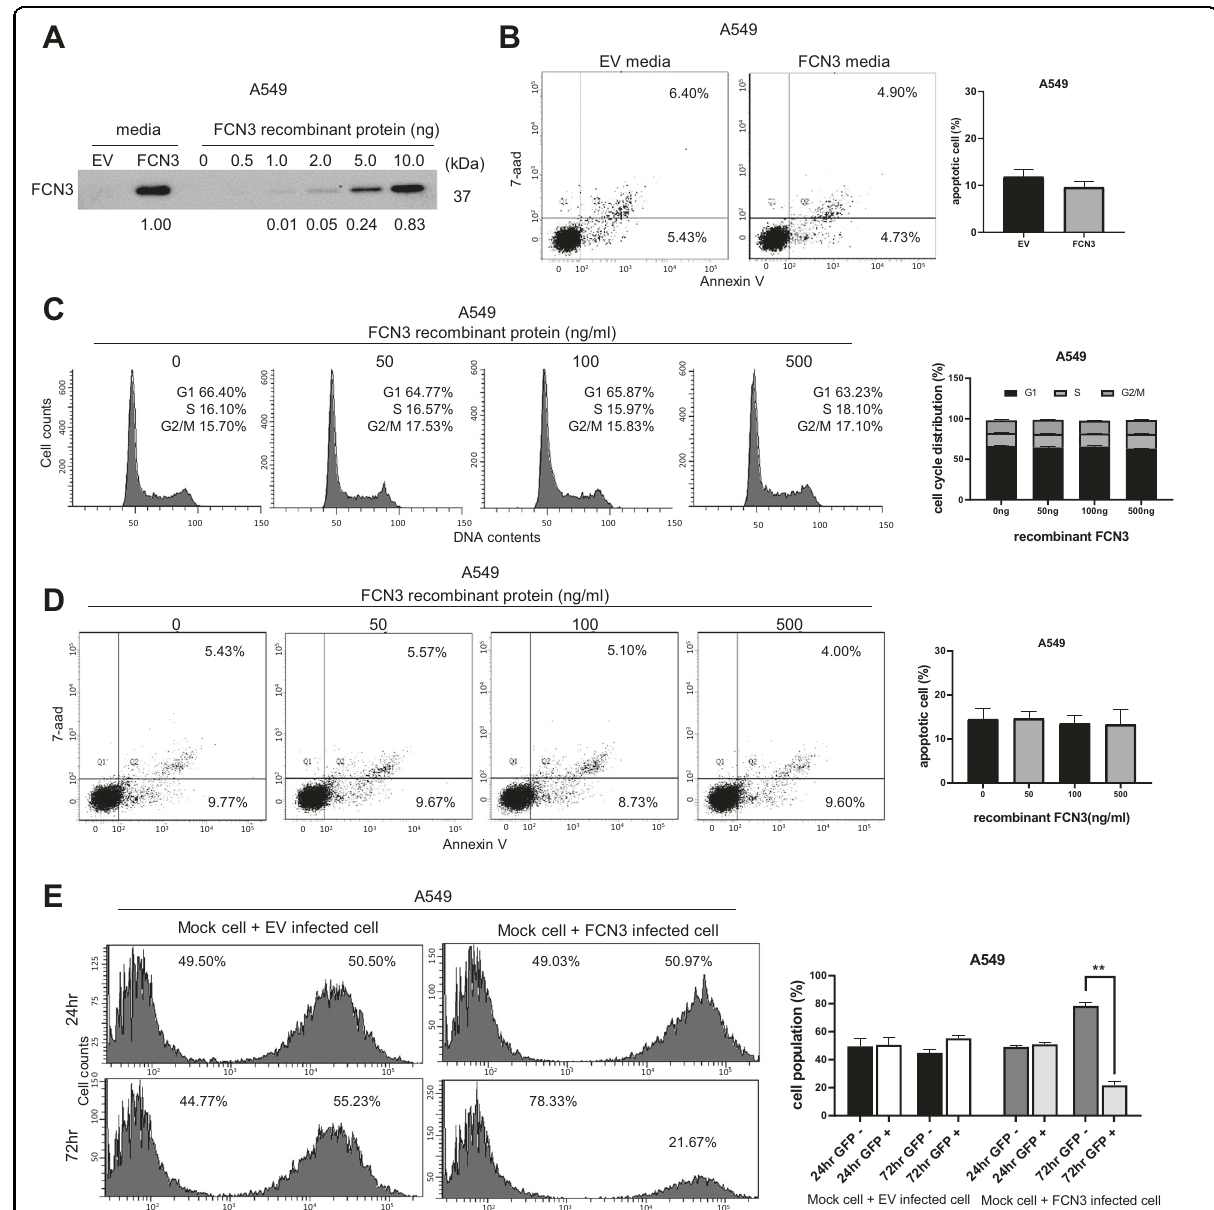
Fig. 4 Tumor suppressor activity of FCN3 involves an intracellular mechanism. A Immunoblot showing the secreted FCN3 in cultured media of FCN3 -virus-transduced A549 cells but not in culture media of control virus (EV)-transduced cells. Indicated amounts of recombinant FCN3 protein are also shown. B Culture media from control virus- or FCN3 -virus-transduced cells were applied to A549 cells, and apoptosis was analyzed by fl ow cytometry after 96 h. Data summarized in the graph are mean ± SEM of three independent experiments. Note no signi fi cant difference was seen. C Cell cycle analyses of A549 cells by fl ow cytometry 72 h after application of indicated doses recombinant FCN3. No alteration in cell cycle progression was observed. Data are mean ± SEM of three independent experiments. D Apoptosis was examined 96 h after application of indicated doses recombinant FCN3. No alteration in proportions of apoptotic cells was noticed. Data are mean ± SEM of three independent experiments. E A549 cells with or without viral transduction were mixed and co-cultured for 24 h and 72 h. Proportions of GFP-negative and -positive cell populations were analyzed by fl ow cytometry. After 72 h, GFP-positive proportion was decreased only in the case of FCN3 -virus-transduced cells. Data are mean ± SEM of three independent experiments, and (**) represents P -value of <0.01 from t